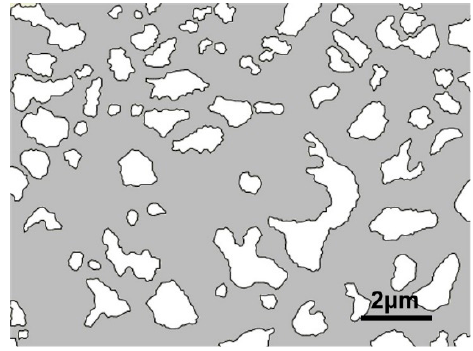
Figure 2. Schematic diagram of the pore profile.